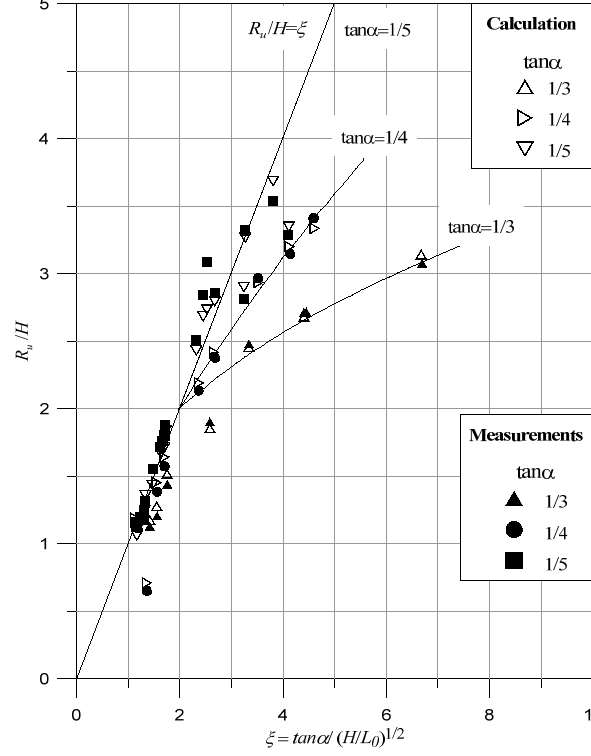
Figure 4. Comparison on the run-up from numerical results with those from measurments. 2 Fig. 4. Comparison on the run-up from numerical results with those from measurements.